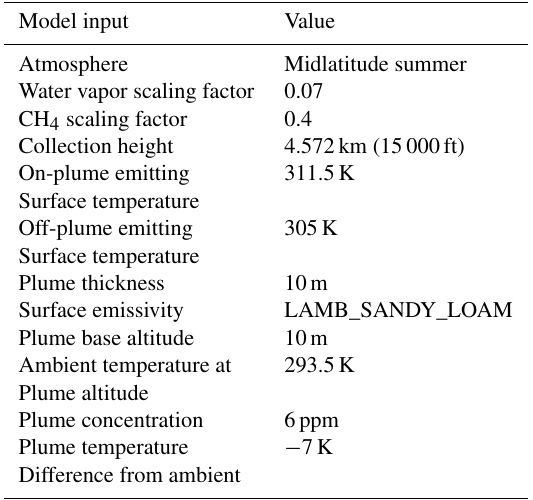
Table 2. MODTRAN Parameter Settings for Validation of HyTES Simulated Radiances.